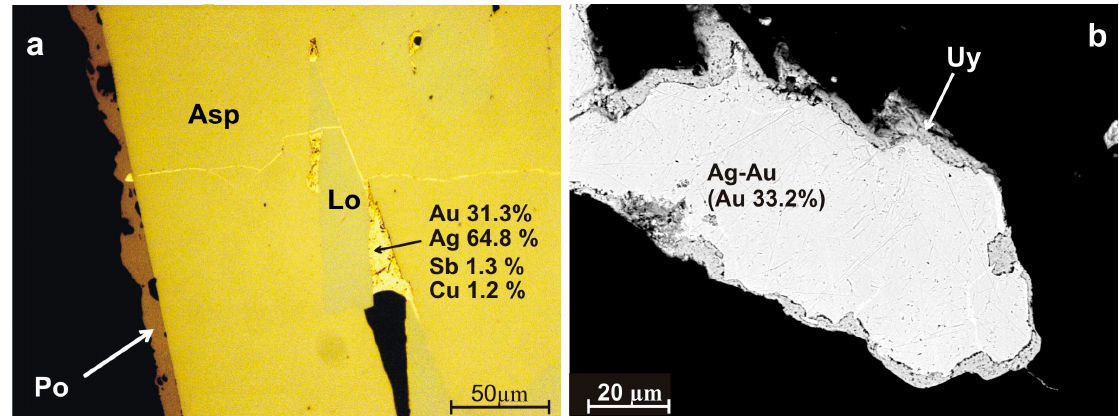
Figure 5. ( a ) Electrum of the 1st type at the boundary arsenopyrite (Asp)–löllingite (Lo) and in fissures in arsenopyrite, reflected light, one polarizer; ( b ) back scattered electron image of uytenbogardtiite, replacing electrum. Table 3. Electron microprobe data in wt.% for native gold and silver from the Oleninskoe and Nyal’m (sample # 62.8–107)